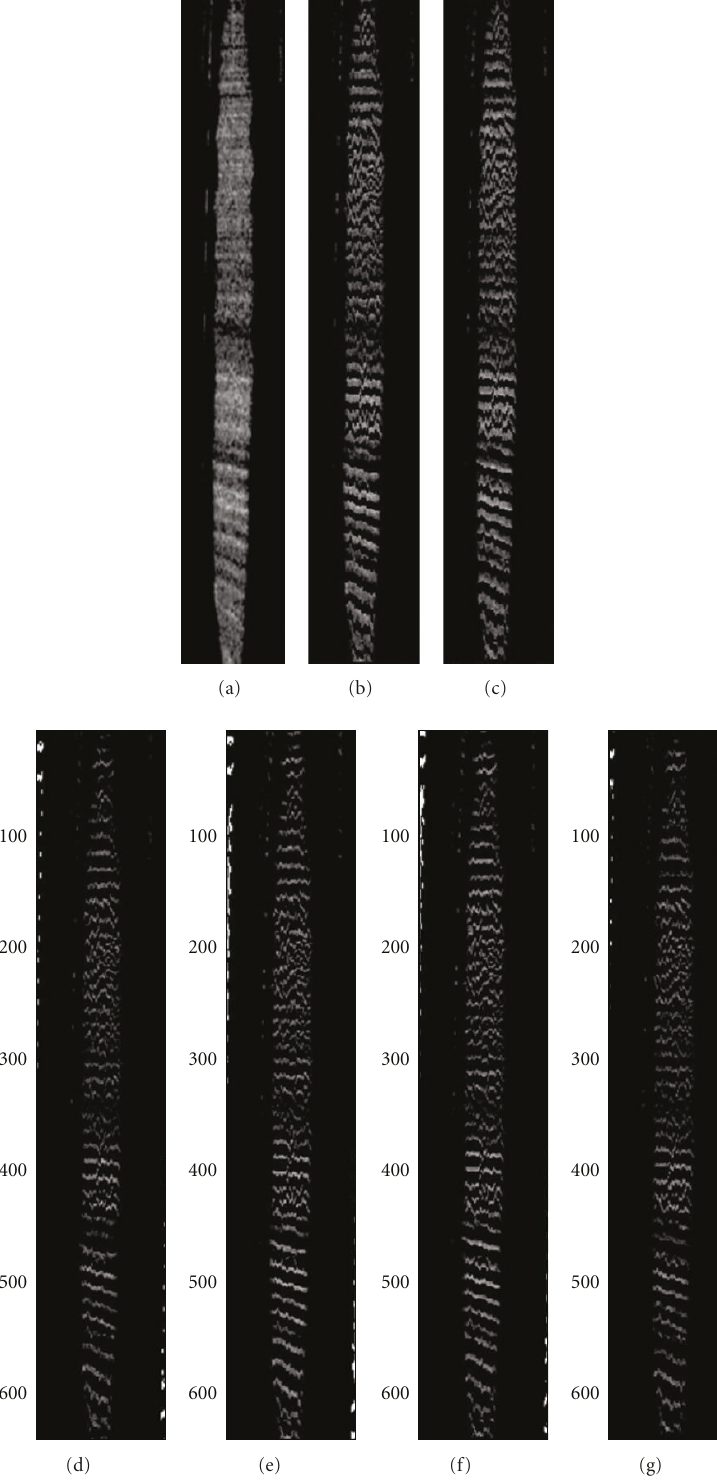
Figure 18: Tree growth estimates using uniform wavelength spacing filterbank: populus sample. (a) original image, (b) first-half season, and (c) second-half season. Quarterly growth estimates: (d) 1st, (e) 2nd, (f) 3rd, and (g) 4th